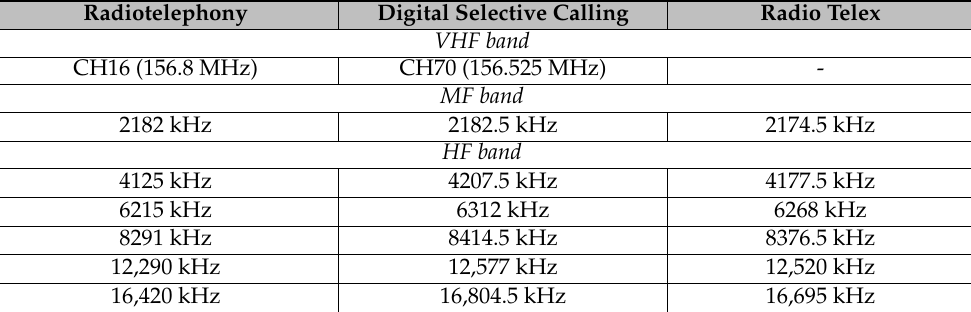
Table 1. Radio Regulations of the International Telecommunication Union